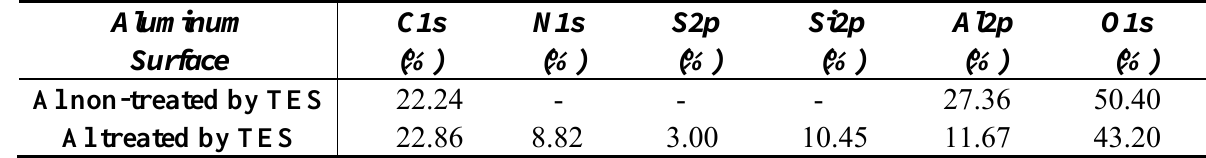
Table 1. Atomic concentrations of TES treated and non-treated aluminum surfaces.